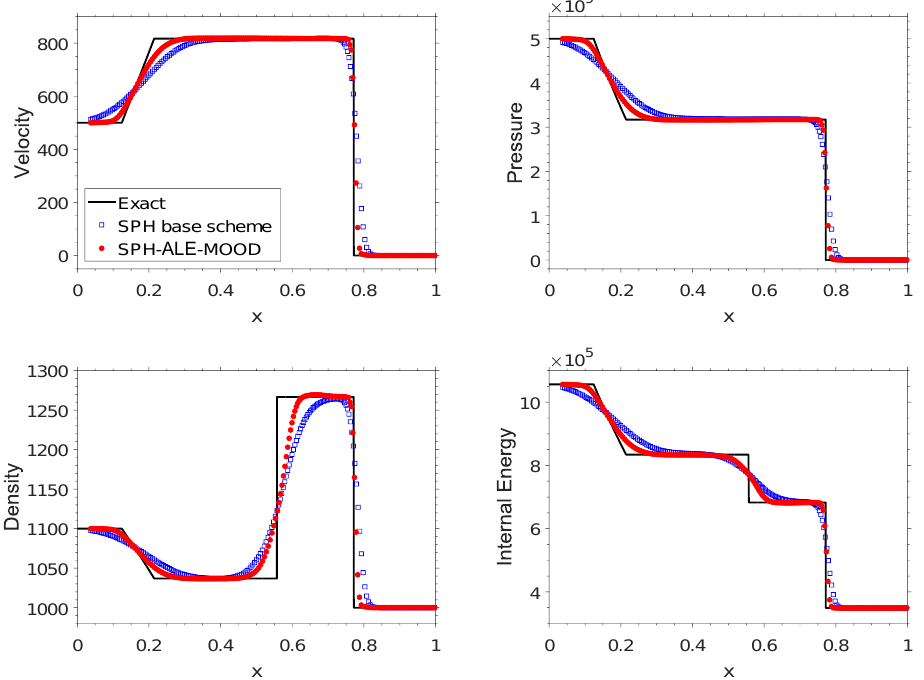
Figure 4. 1D Sod shock tube problem (T2): Simulations results at t final = 7 × 10 − 5 s using 200 par- ticles in the domain [ 0,1 ] m. We plot velocity ( top-left ), pressure ( top-right ), density ( bottom-left ), and internal energy ( bottom-right ). Results obtained using the SPH base scheme ( empty squares ) and the SPH-ALE-MOOD method ( filled circles